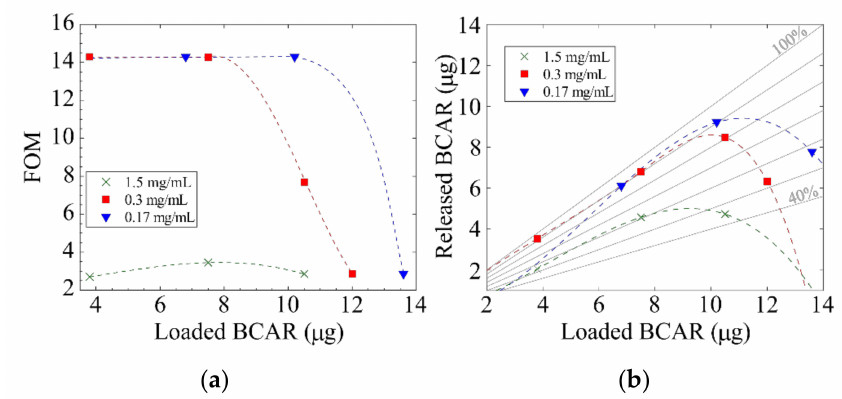
Figure 5. ( a ) FOM vs. the amount of loaded BCAR. Large FOM indicates nearly quantitative and reproducible release of the cargo. ( b ) Absolute release of BCAR vs. loaded amount for the di ff erent loading solutions. Gray oblique lines indicate percentage of release. Dotted lines are guides for the eyes.